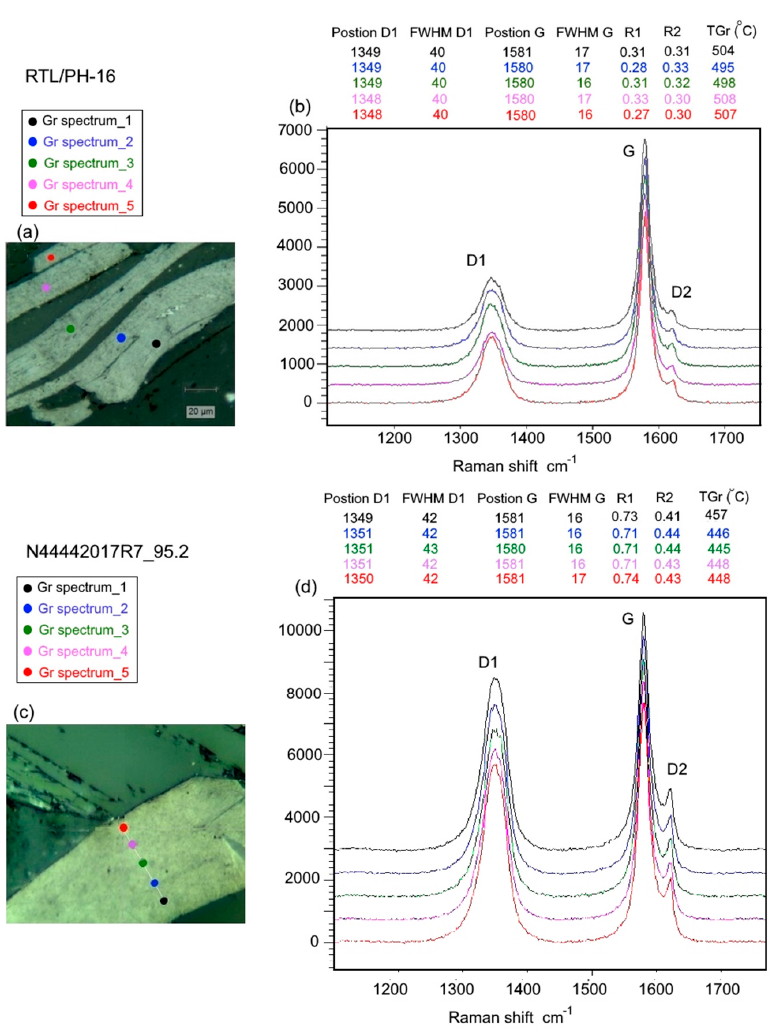
Figure 5. ( a , c )Optical microscope images of graphite flakes from two samples, RTL_PH16 and N4442018_95.7; ( b , d ) Raman spectrum of single graphite flakes. The color of Raman spectrum corresponds to the color of the spot where the spectrum was acquired. Table 3. Raman spectra parameters from petrographic thin section and the peak of the